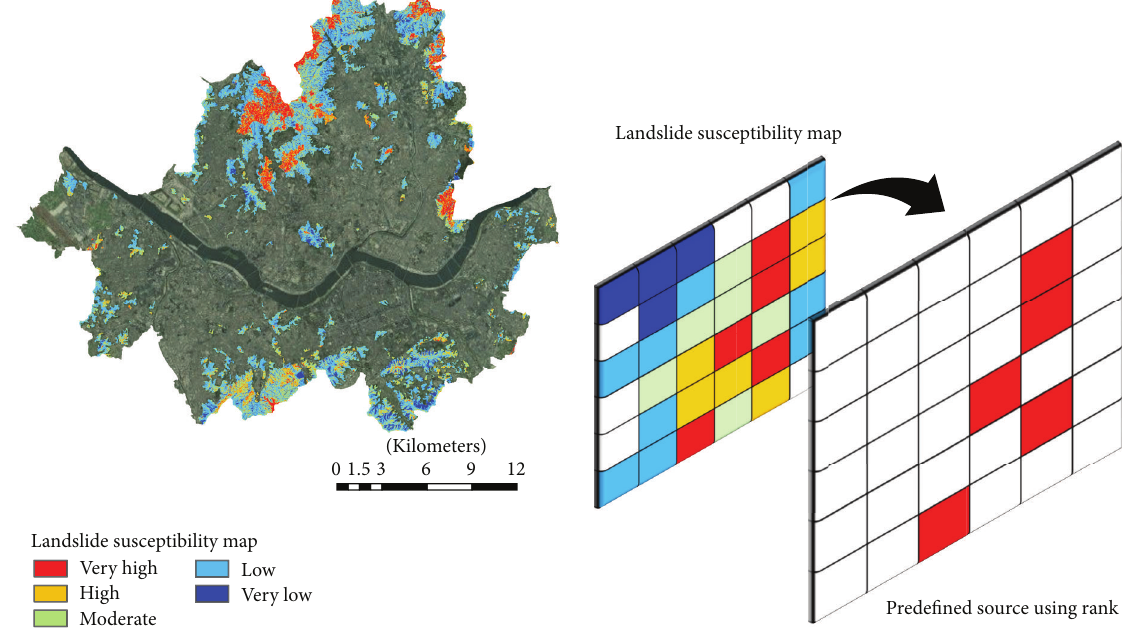
Figure 2: Identification of predefined source areas using landslide susceptibility map.